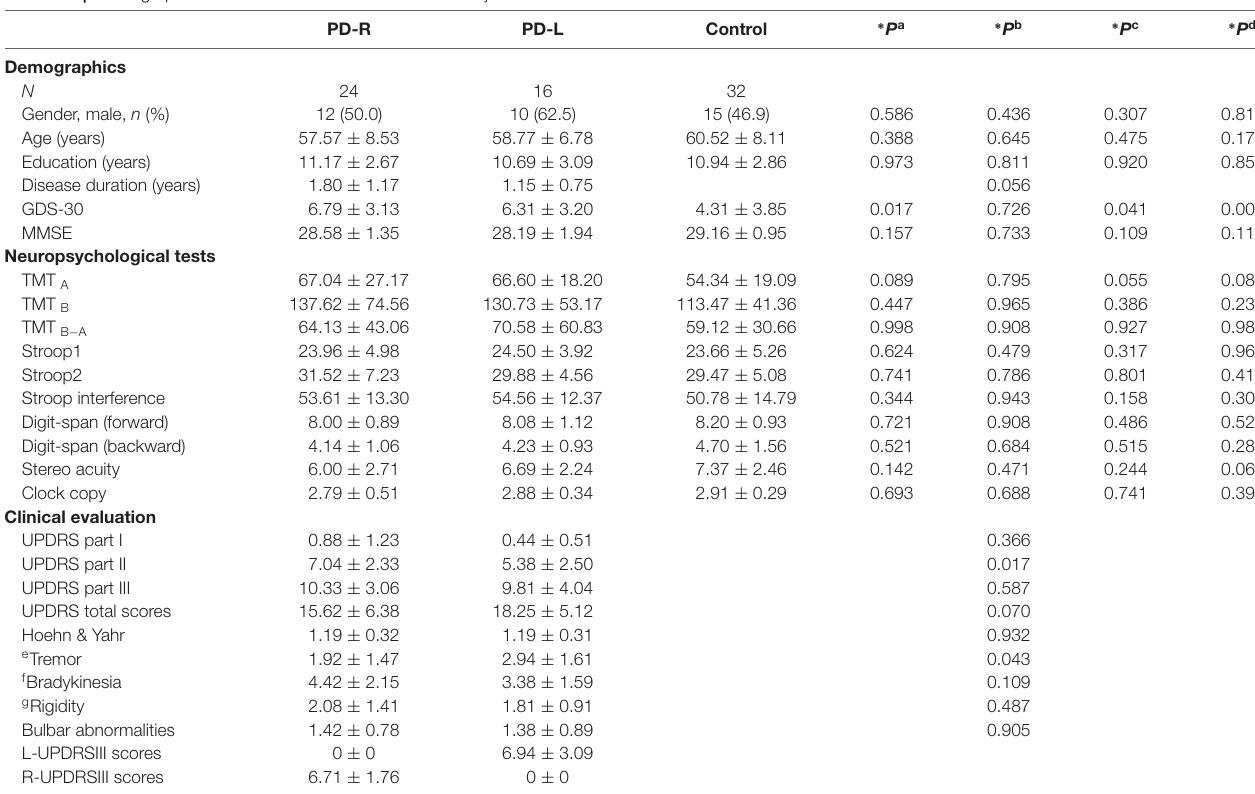
TABLE 1 | Demographic and disease characteristics of the subjects. PD-R PD-L Control ∗ P a ∗ P